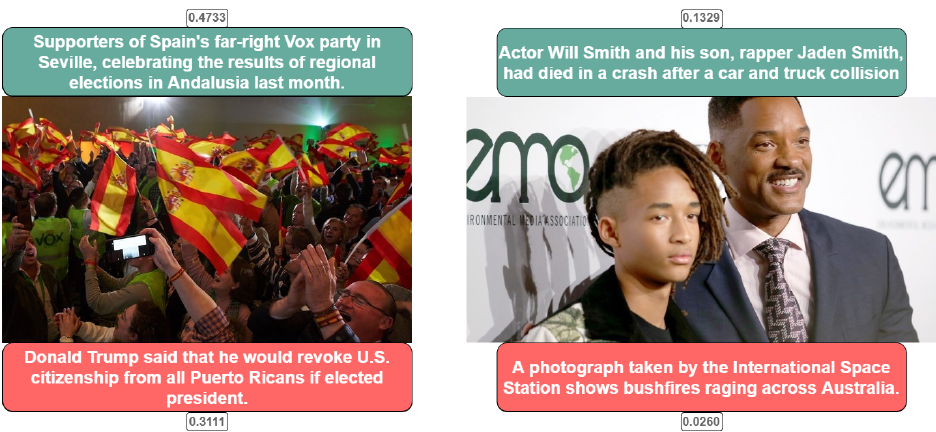
Figure 5. Example of the matching score between image and caption. Green expresses